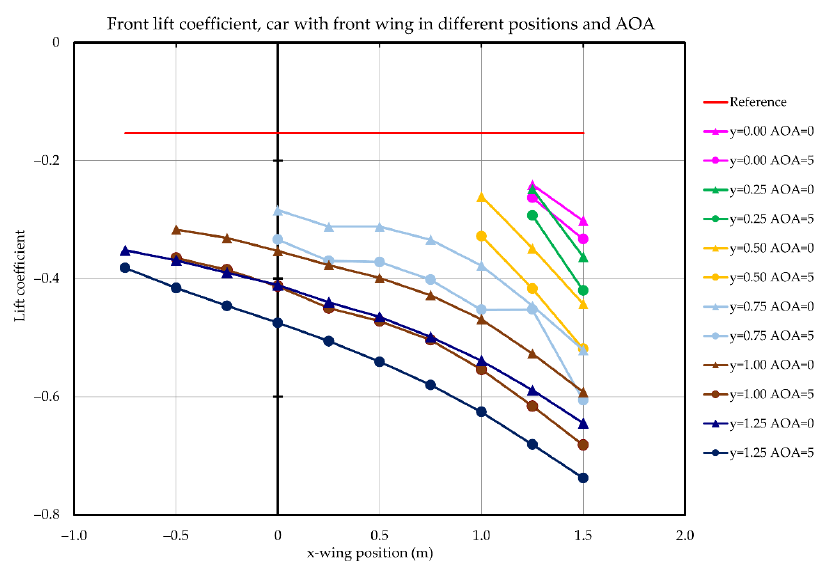
Figure 25. Variations in lift force acting on the front axle of the vehicle as a function of wing position relative to the body and as a function of the angle of attack (AOA).